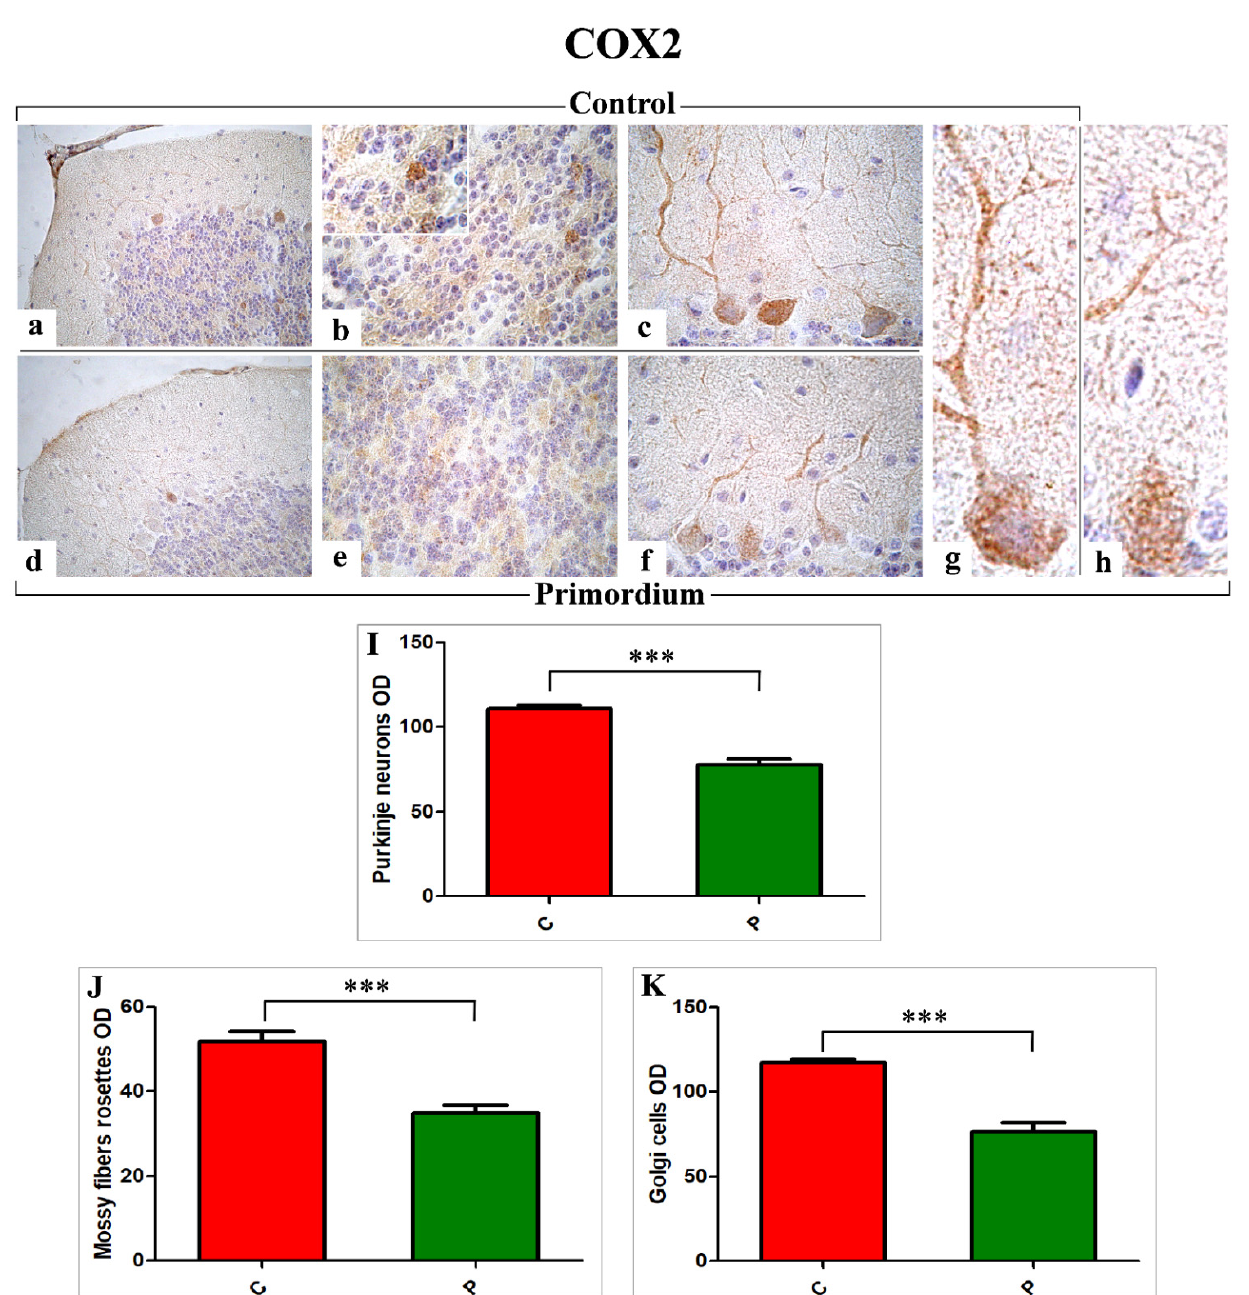
Figure 4. Immunohistochemical labelling for COX2 in C animals ( a – c , g ) and P ( d – f , h ) mice. Panels ( I – K ): Histograms showing the quantitative analysis of COX2 immunopositive PCs, mossy fiber rosettes, and GCs OD, respectively. p values calculated by unpaired Student’s t -test: p < 0.001 (***).